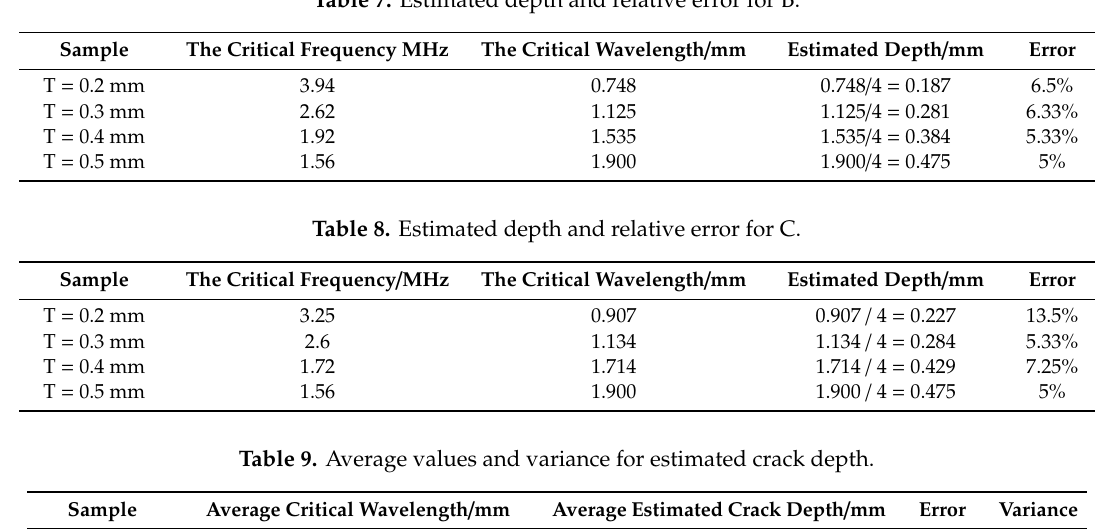
Table 7. Estimated depth and relative error for B.